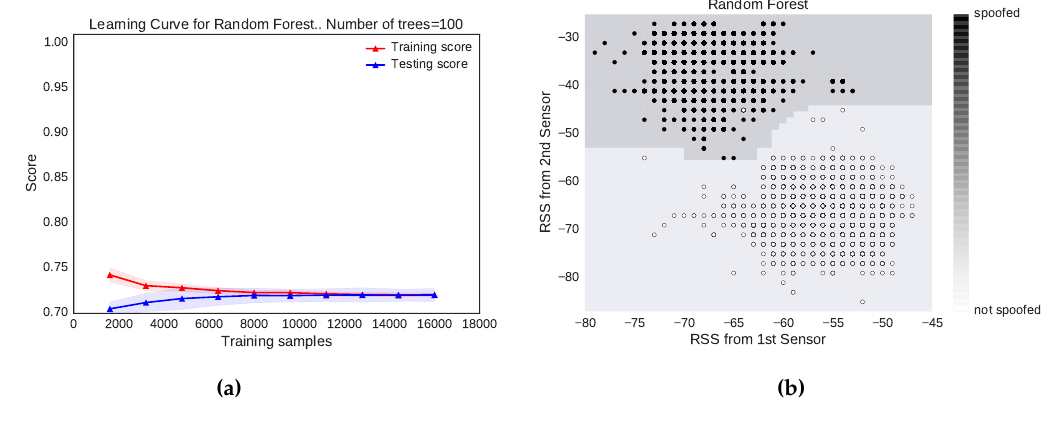
Figure 3. Optimization and data separation. ( a ) Learning curve of random forests with 100 trees for Locations 6 vs. 7; ( b ) performance of random forests when the attacker and legitimate device are 10 m